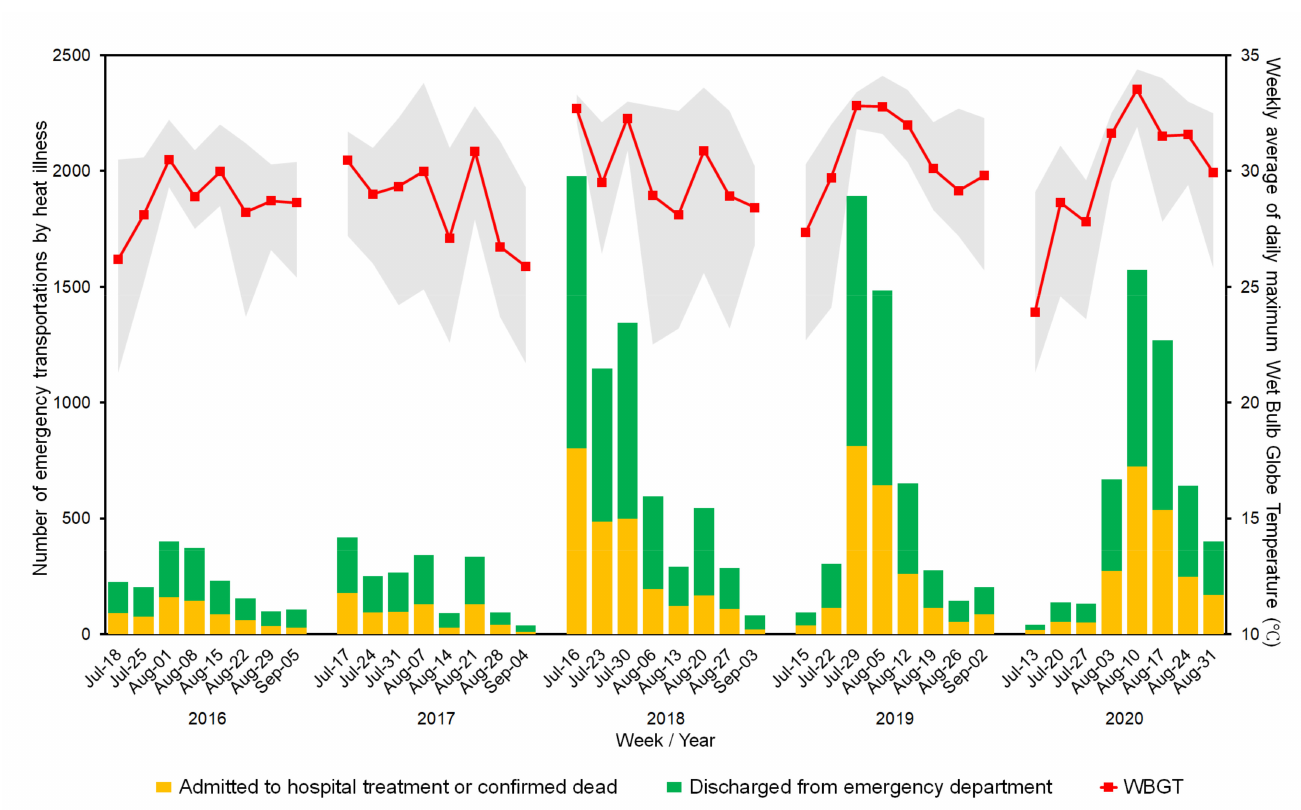
Figure 2. Number of emergency transportations due to heat illness by disposition and weekly averages of daily maximum Wet Bulb Globe Temperature (WBGT) in Tokyo in 2016–2020. Yellow indicates the number of heat illness patients requiring admission, or confirmed dead, while green shows mild cases of patients who did not need admissions. The red line shows the trend in the weekly averages of daily maximum WBGT. Gray-shaded areas represent the variation of daily maximum WBGT in each